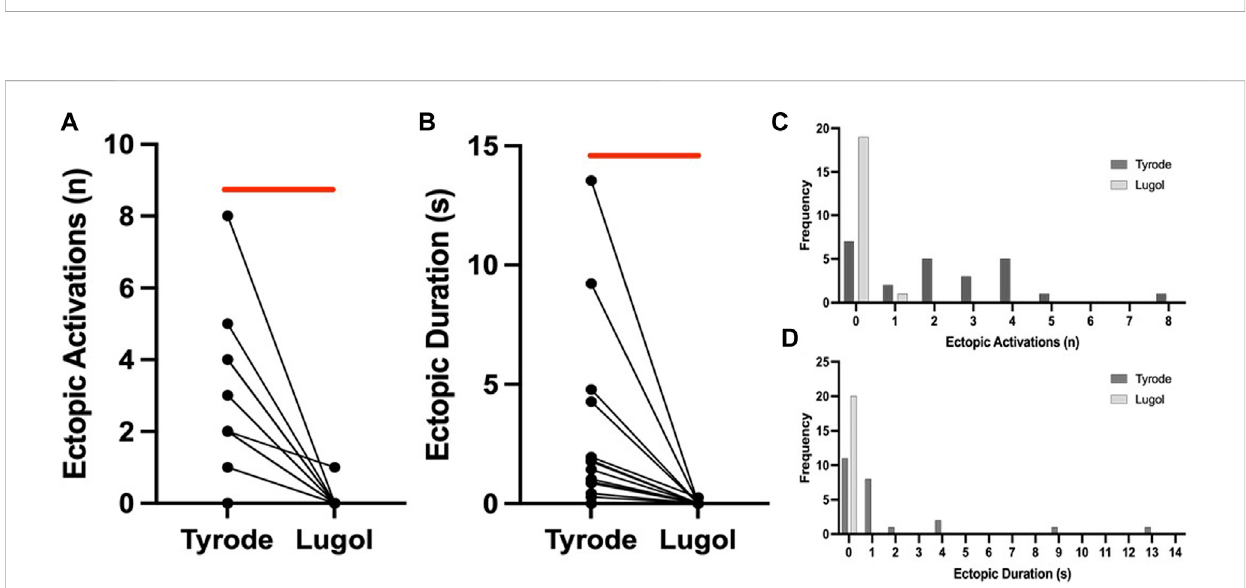
FIGURE 2 Lugol decreases the number and duration of stretch-induced ectopics. Number of ectopics (A) and duration of ectopics (B) for paired stretches before(Tyrode)andafter(Lugol)exposuretoLugol.AfterexposuretoLugol,asigni fi cantreductioninthenumberanddurationofmechanically-activated ectopics was recorded (red bar). Data from 20 paired stretches from 7 hearts, Wilcoxon signed ranks test for ectopic number and paired Student ’ s t-test for duration. With either n = 20 stretches or n = 7 hearts (Tyrode vs. Lugol, p < 0.05), symbols may represent more than 1 pair of data. Frequency histograms for ectopic number (C) and duration (D) , a leftwards shift in both parameters is visible after exposure to Lugol, 24 stretches from 8 hearts in Tyrode and 20 stretches from 7 hearts for